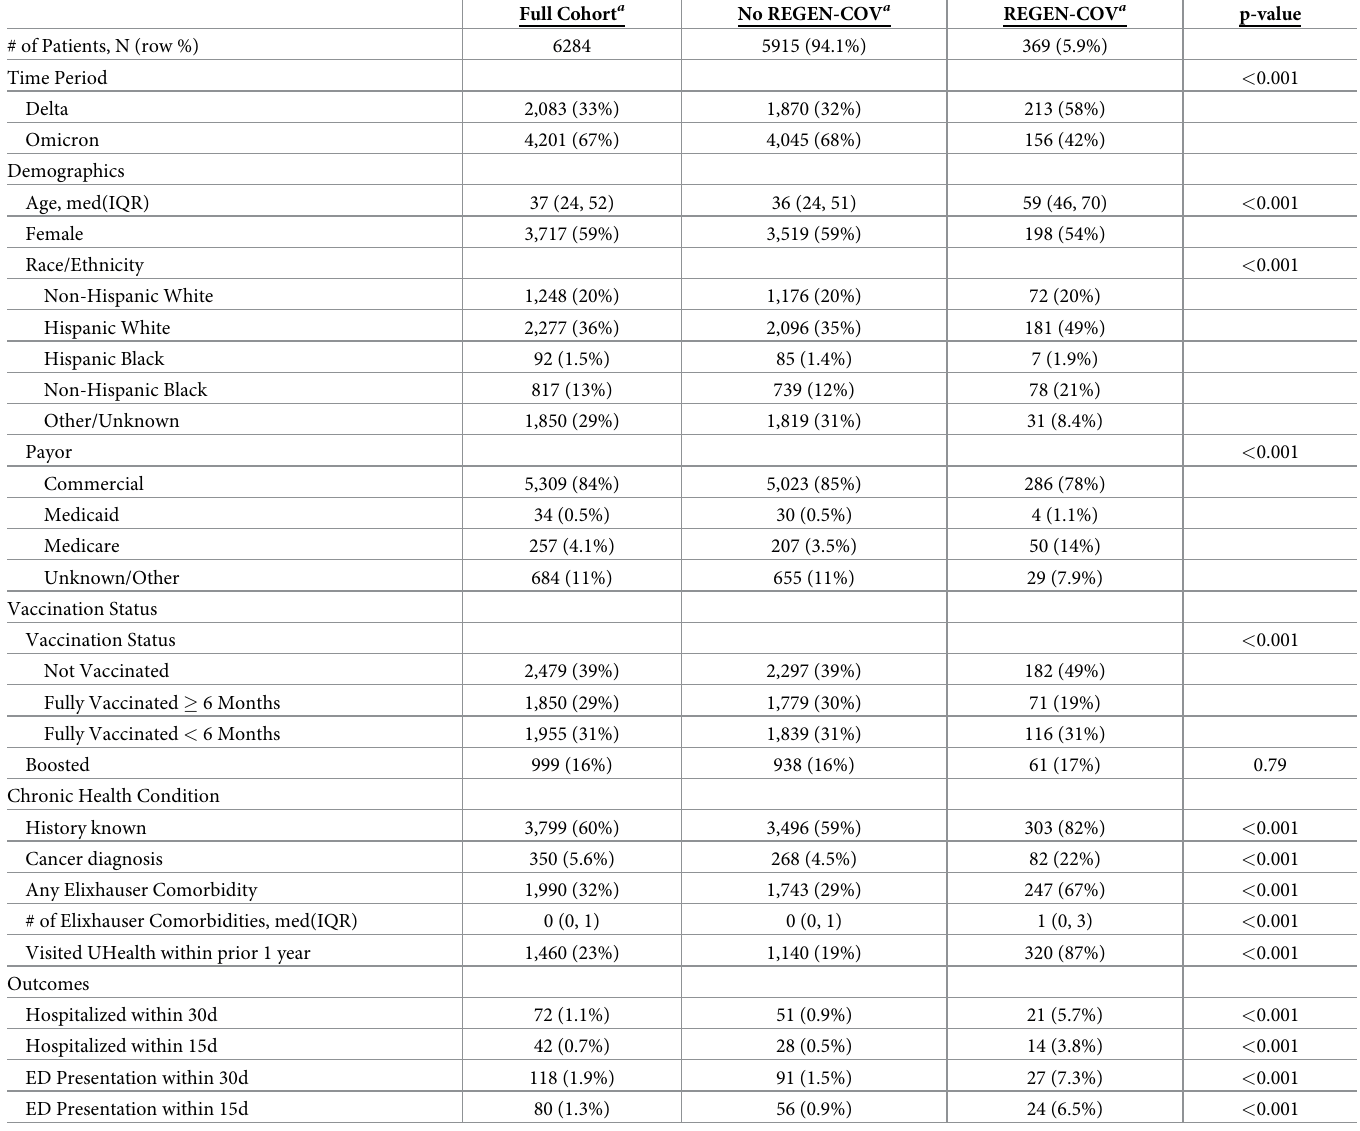
Table 1. Cohort characteristics by REGEN-COV